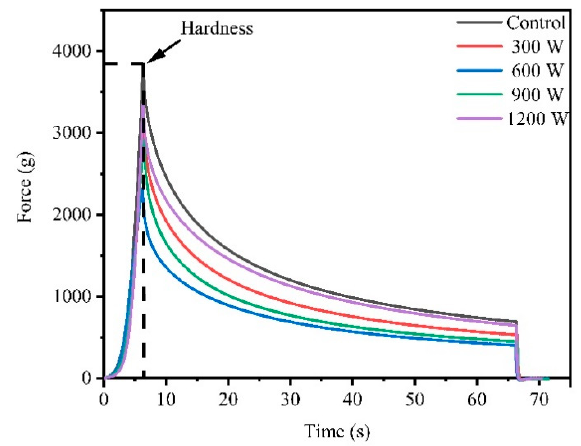
Figure 2. Effect of different ultrasound power on stress relaxation of wooden breast (WB).